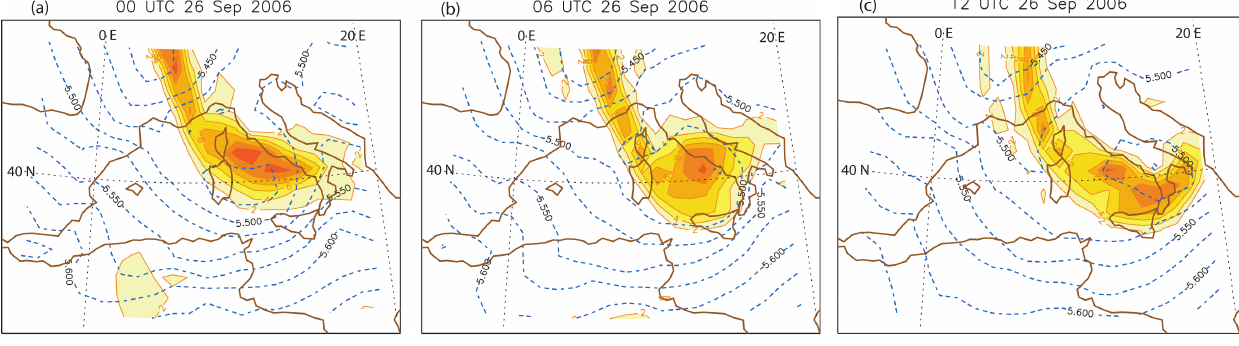
Fig. 8. ECMWF operational 1000–500hPa geopotential thicknesses (in 10 4 m 2 /s 2 ) and potential vorticity at 250hPa (in PV Units) for 26 September 2006 at (a) 00:00UTC, (b) 06:00UTC, and (c)